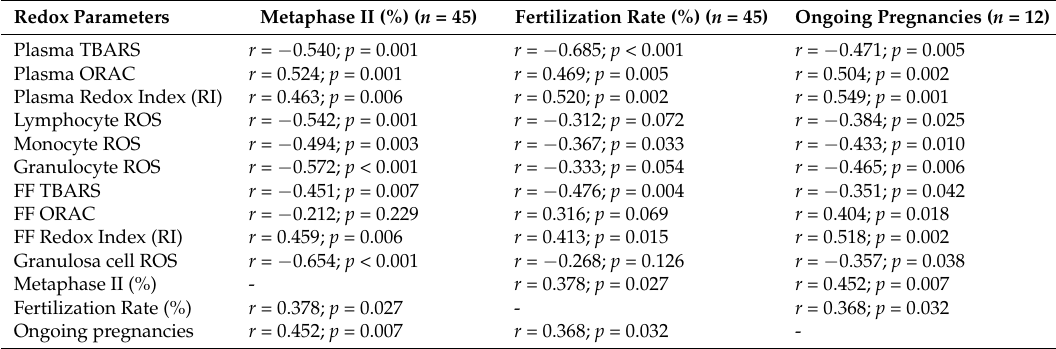
Table 2. Partial correlation coefficients between the investigated redox parameters and in vitro fertilization (IVF) outcome after controlling for endometriosis, age, smoking habits, BMI, IVF-ET/ICSI, FSH, LH, estradiol, AMH, and duration of infertility. FF: follicular fluid. Redox Parameters Metaphase II (%) ( n = 45) Fertilization Rate (%) ( n = 45) Ongoing Pregnancies ( n =